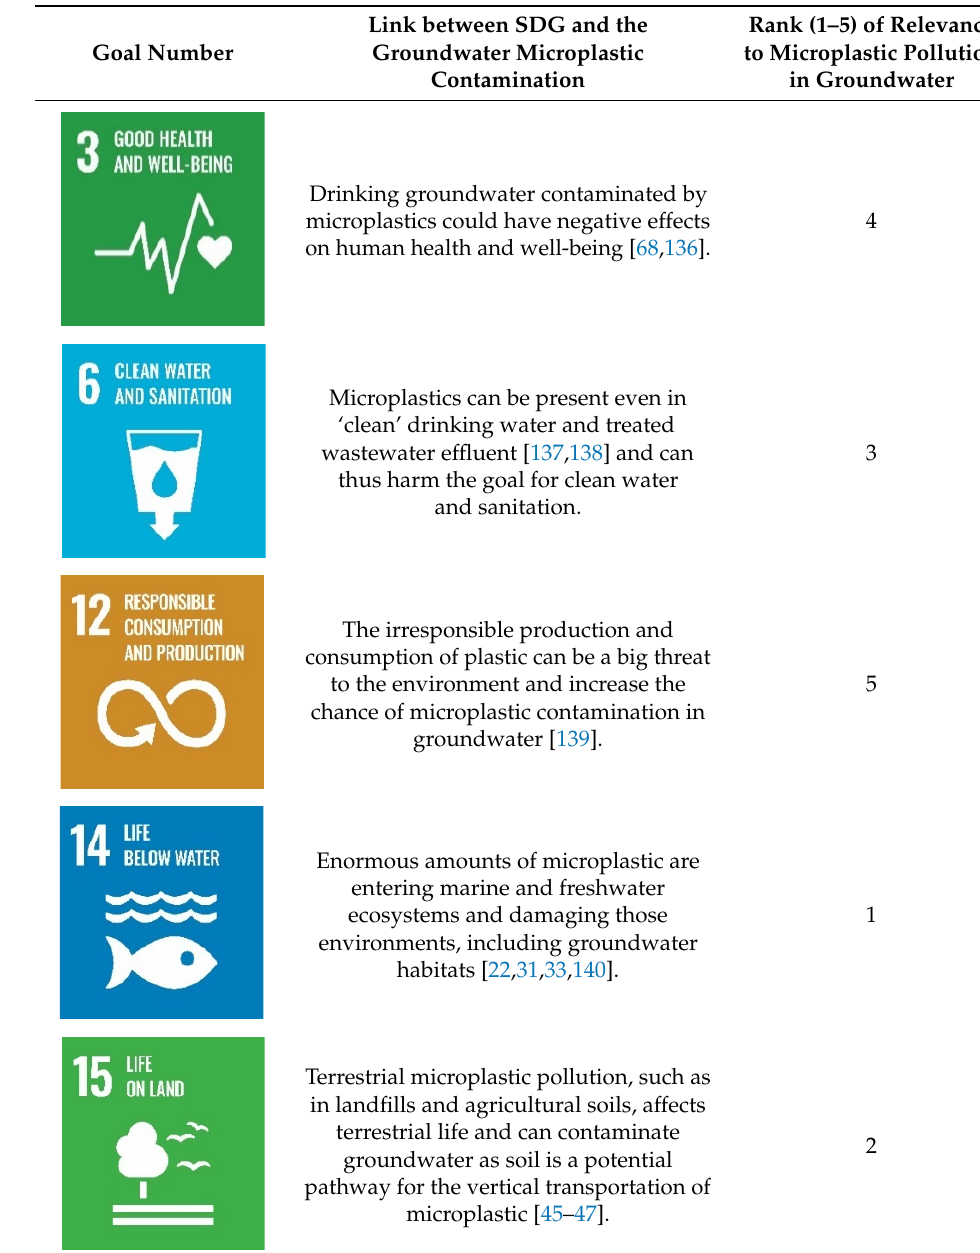
Table 3. Interlinkage of the Sustainable Development Goals and the Groundwater Microplastic Contamination Issue.